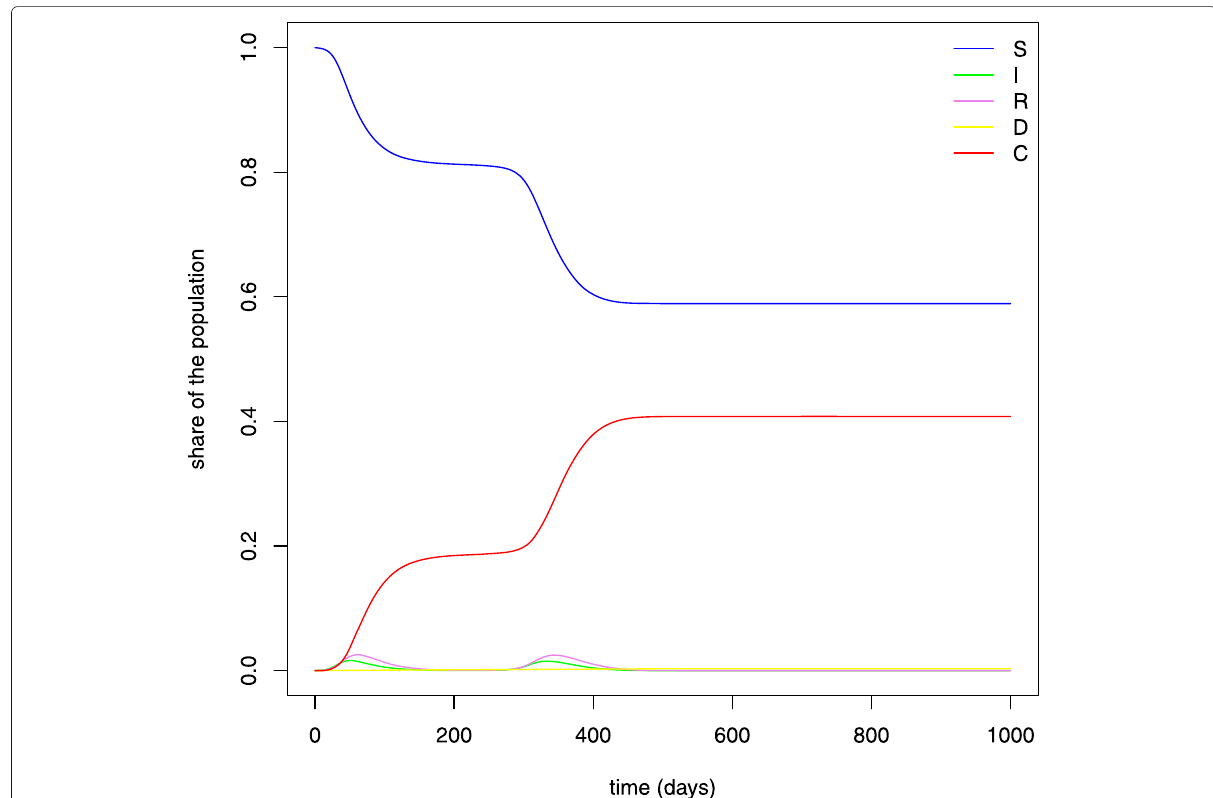
Fig. 6 SIRDC model–time horizon: 1000 days. Note: This figure plots the evolution of the daily shares of individuals in each compartment according to the predictions of our SIRDC model in the absence of restrictions on the time horizon